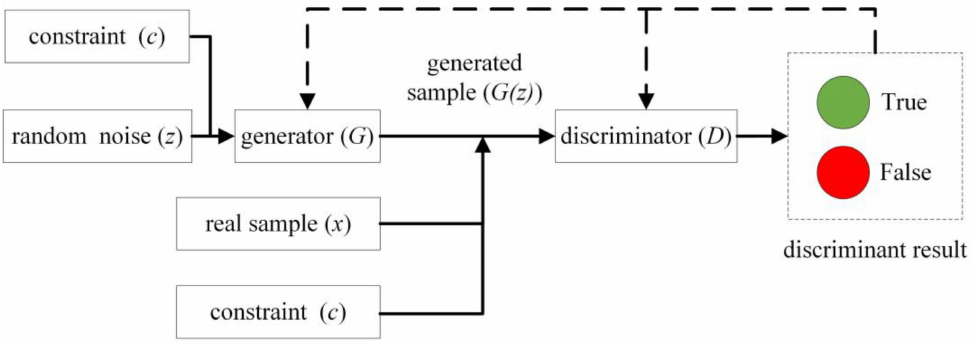
Figure 2. CGAN network